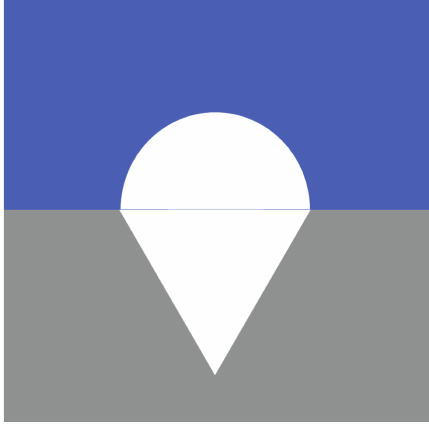
F 2: Sketch of bubble